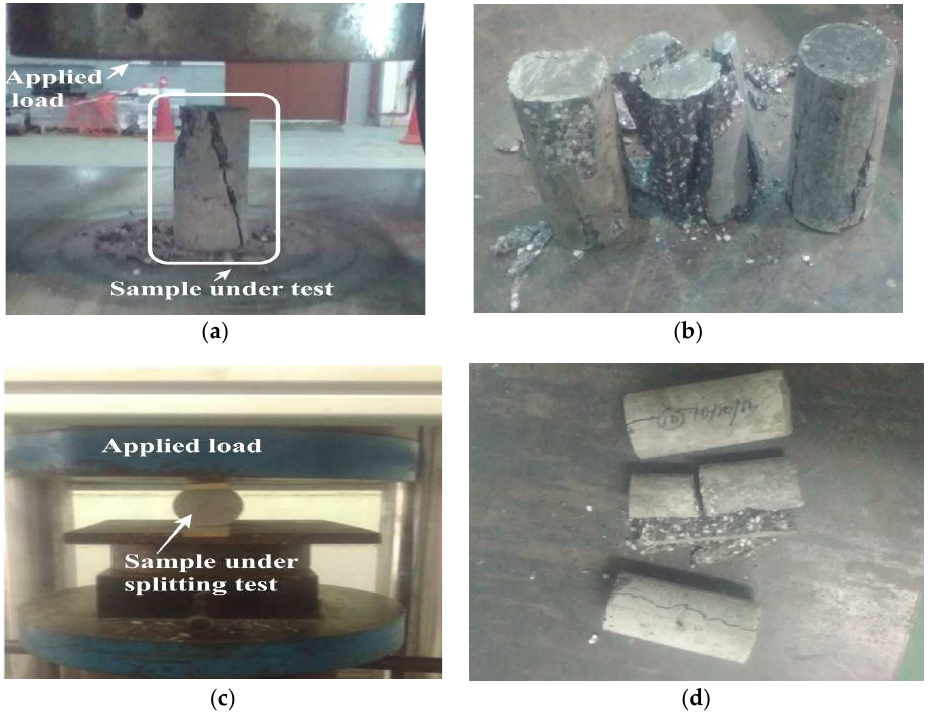
Figure 3. Testing of concrete cylinders: ( a ) cylinder under compressive test; ( b ) cylinders after compression tests; ( c ) cylinder under splitting test; ( d ) cylinders after splitting tests.